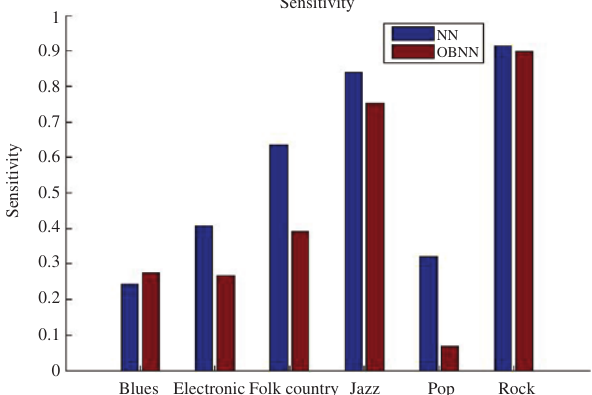
Figure 3: Sensitivity comparisons of the proposed and Existing